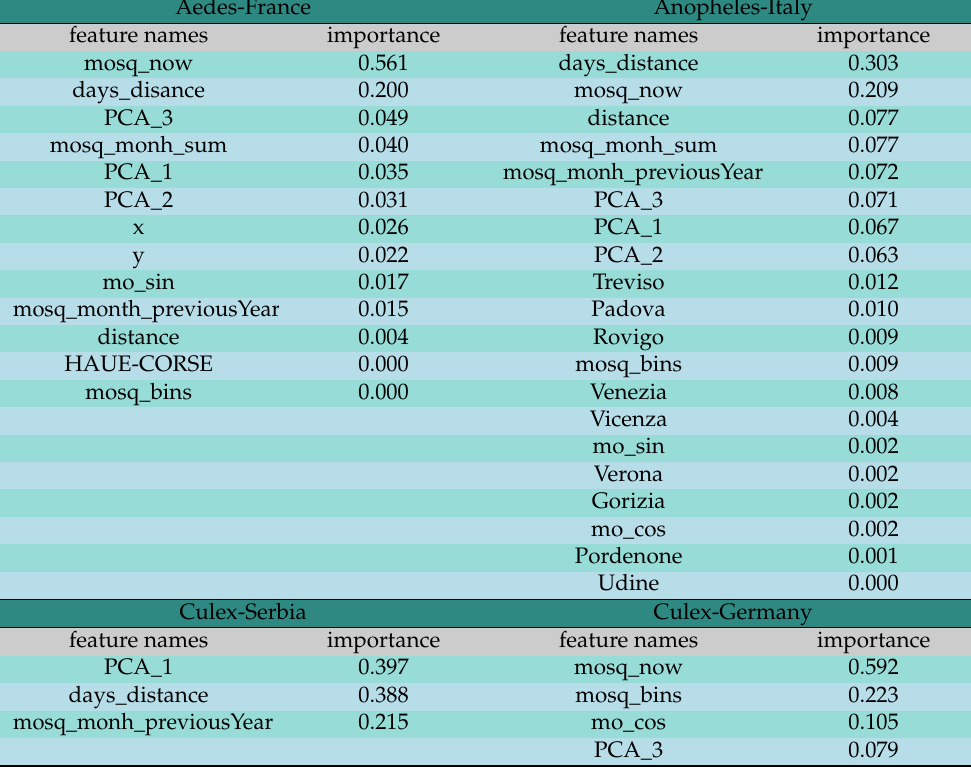
Table A4. Most important features per case without using EO